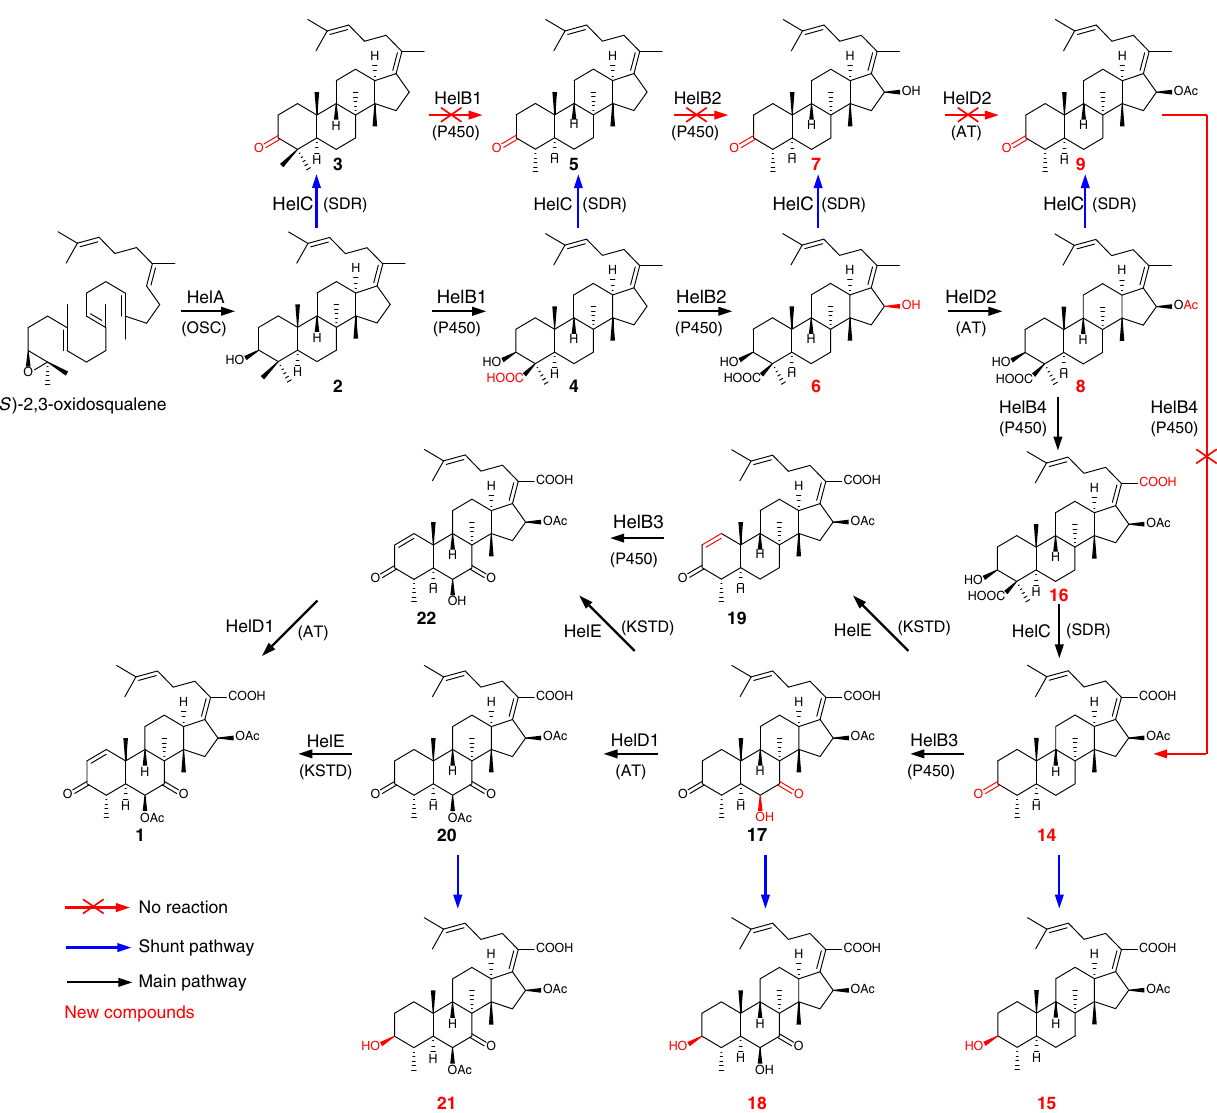
Fig. 4 Complete biosynthetic pathway of helvolic acid. Biosynthesis of helvolic acid includes nine steps from the universal triterpenoid progenitor (3 S )-2,3- oxidosqualene. Following the cyclization to the tetracyclic protosta-17(20) Z ,24-dien-3 β -ol ( 2 ) by HelA, HelB1-mediated and HelB2-mediated oxidation at C-4 and C-16, HelD2-dependent acetylation of 16-OH, oxidation of C-21 by HelB4, and HelC-dependent oxidative decarboxylation yield the fusidane skeleton 14 , which is further modi fi ed in three additional steps mediated by HelB3, HelD1, and HelE to give helvolic acid. The premature decarboxylation (or dehydrogenation) by HelC prevents HelB1-mediated, HelB2-mediated, HelD2-mediated, and HelB4-mediated